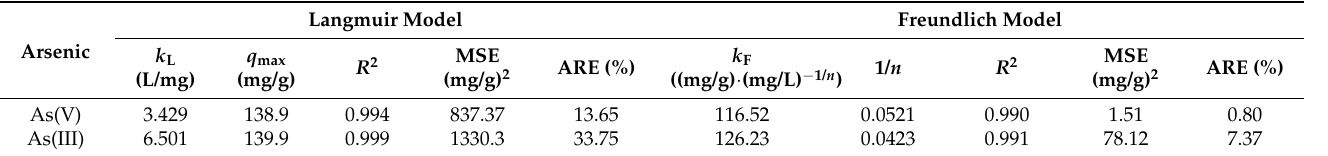
Table 2. Adsorption kinetic parameters for As(V) and As(III) adsorption onto MnO 2 @La(OH) 3 nanocomposite at pH 4.0.